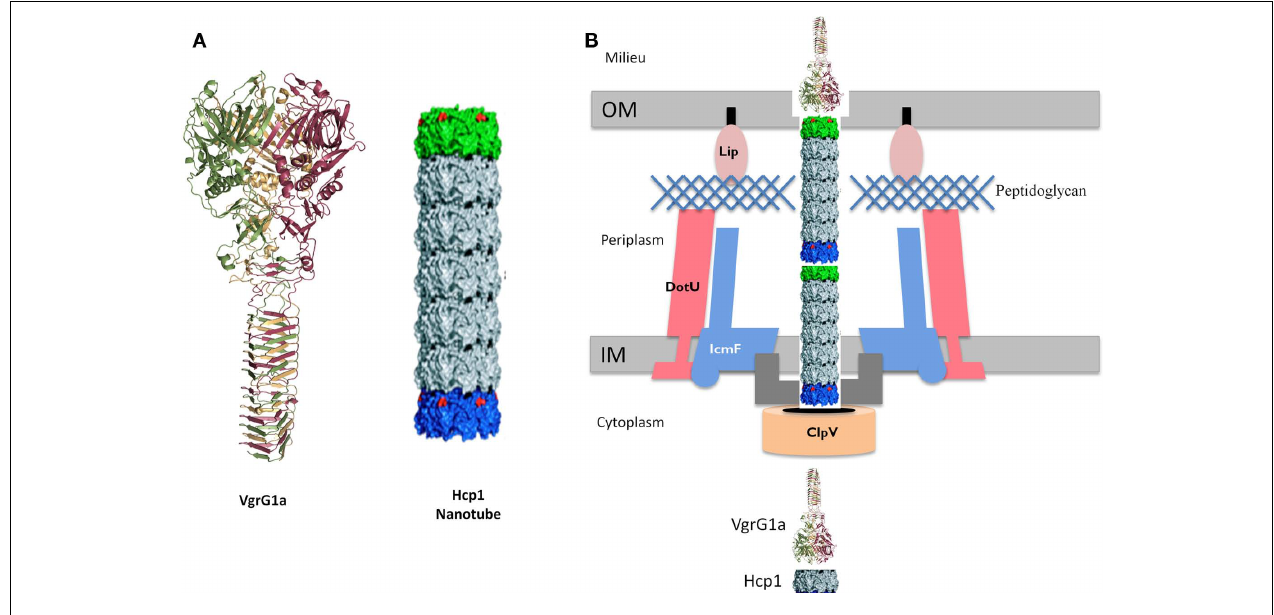
(puncturing device) and Hcp1 nanotube have been included as depicted in (A) . Few otherT6SS components are shown and the system punctures the bacterial cell envelope from inside to outside. See text for more